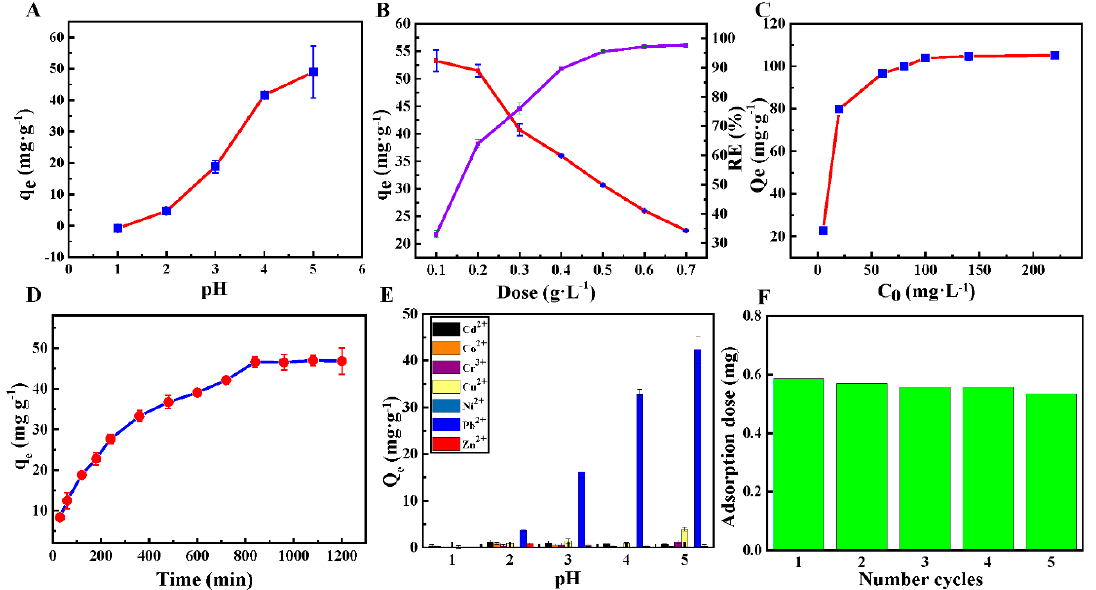
Figure 3. Effect of pH ( A ), adsorbent dose ( B ), concentration of Pb ions ( C ), adsorption kinetics of Pb 2+ onto HHTB ( D ) and coexisting ions on the adsorption ( E ); HHTB to Pb 2+ adsorption dose and recycling ( F ).